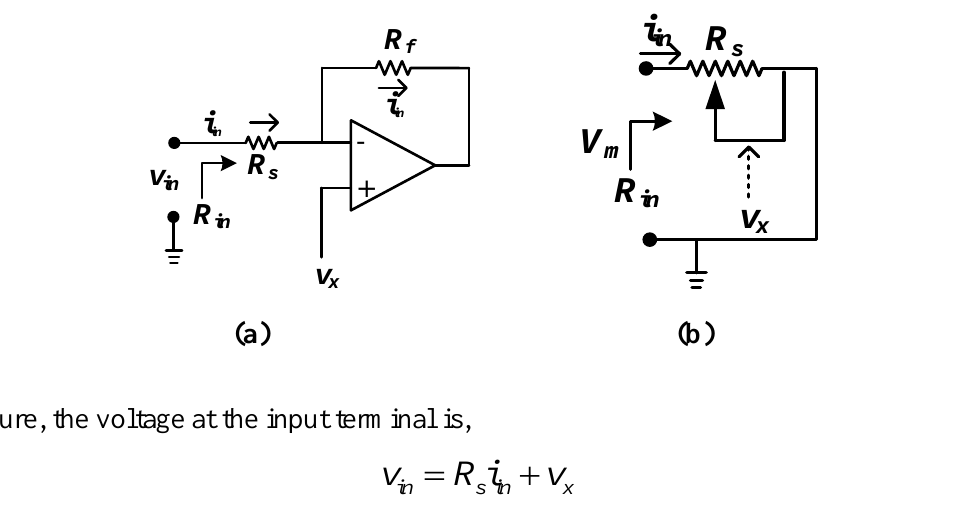
Figure 2. Basic concept for implementing the memristor emulator ( a ) input resistance as a function of voltage v ; ( b ) equivalent x